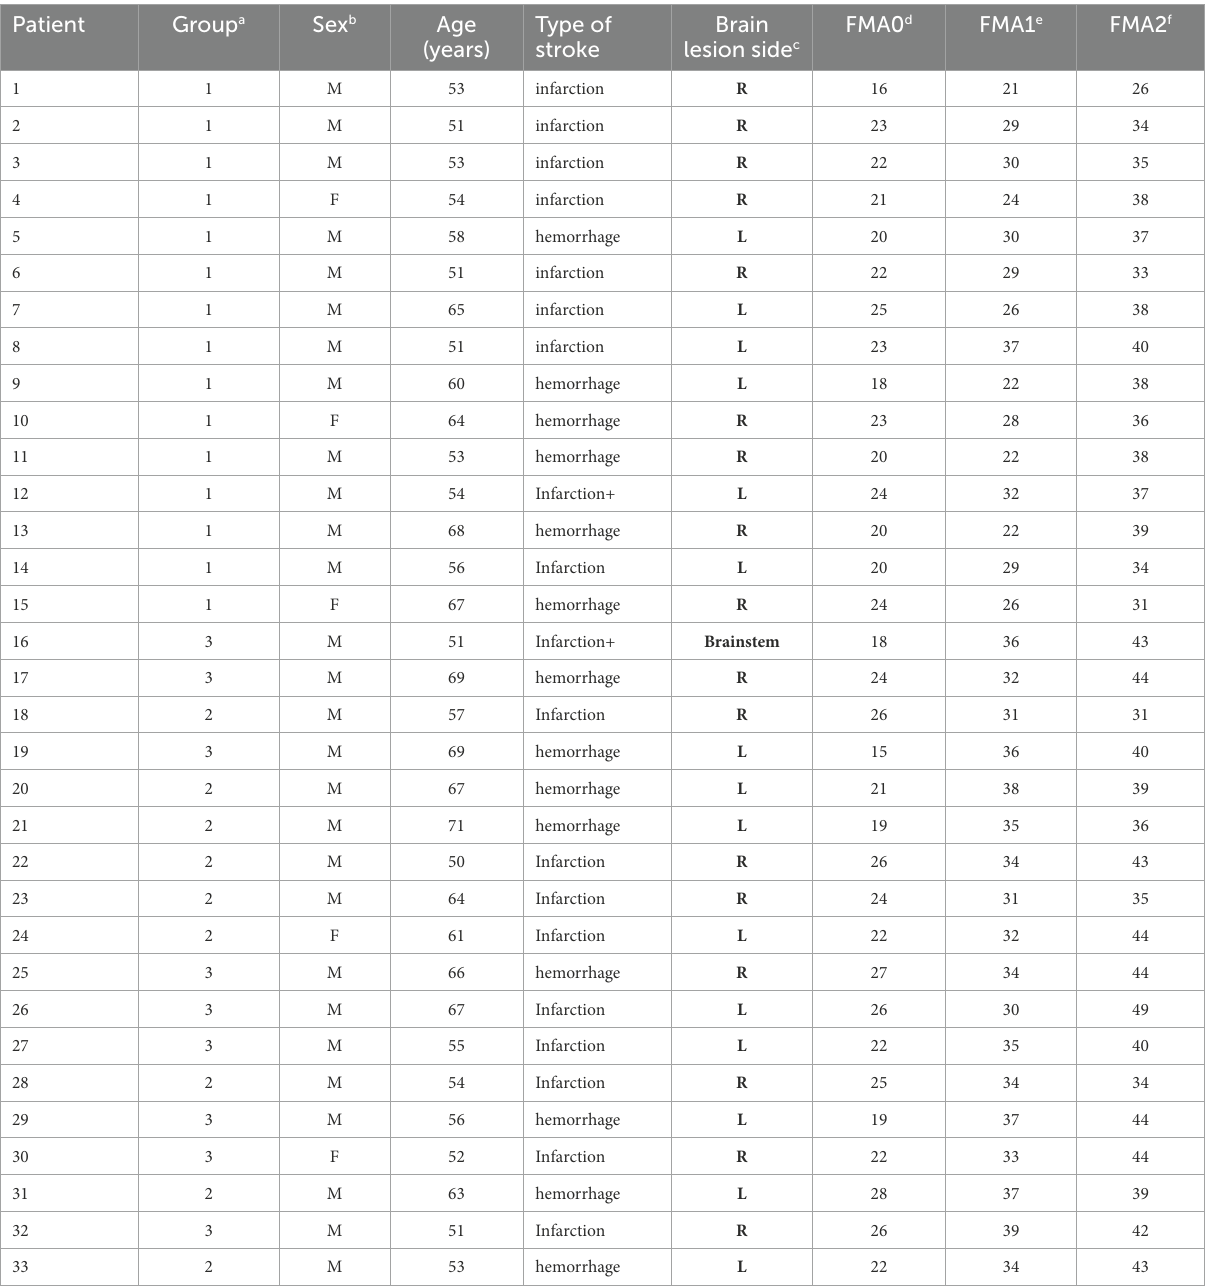
TABLE 1 Demographic data and clinical history of the